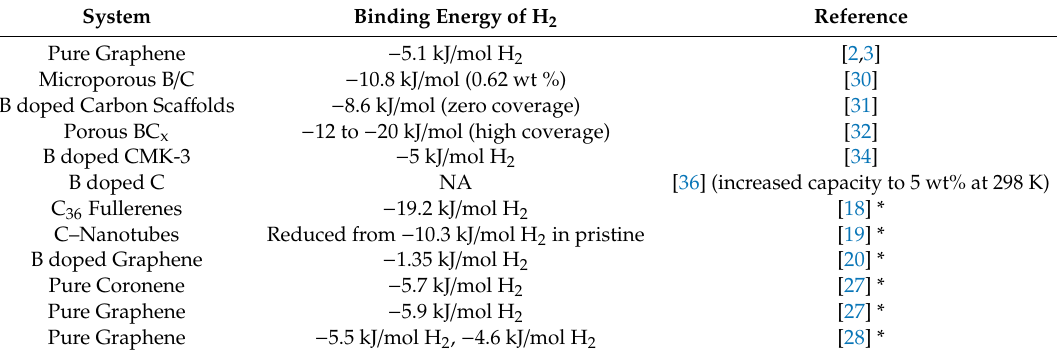
Table 1. Binding energy of H 2 (kJ / mol H 2 ) on carbon and boron–doped carbon materials. The * denotes calculated